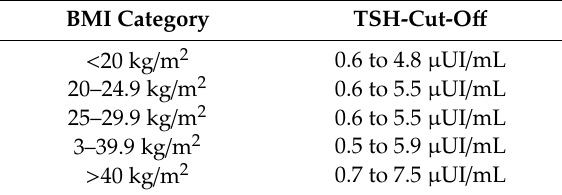
Table 9. Normative range of TSH cut-o ff s proposed on the basis of body mass index